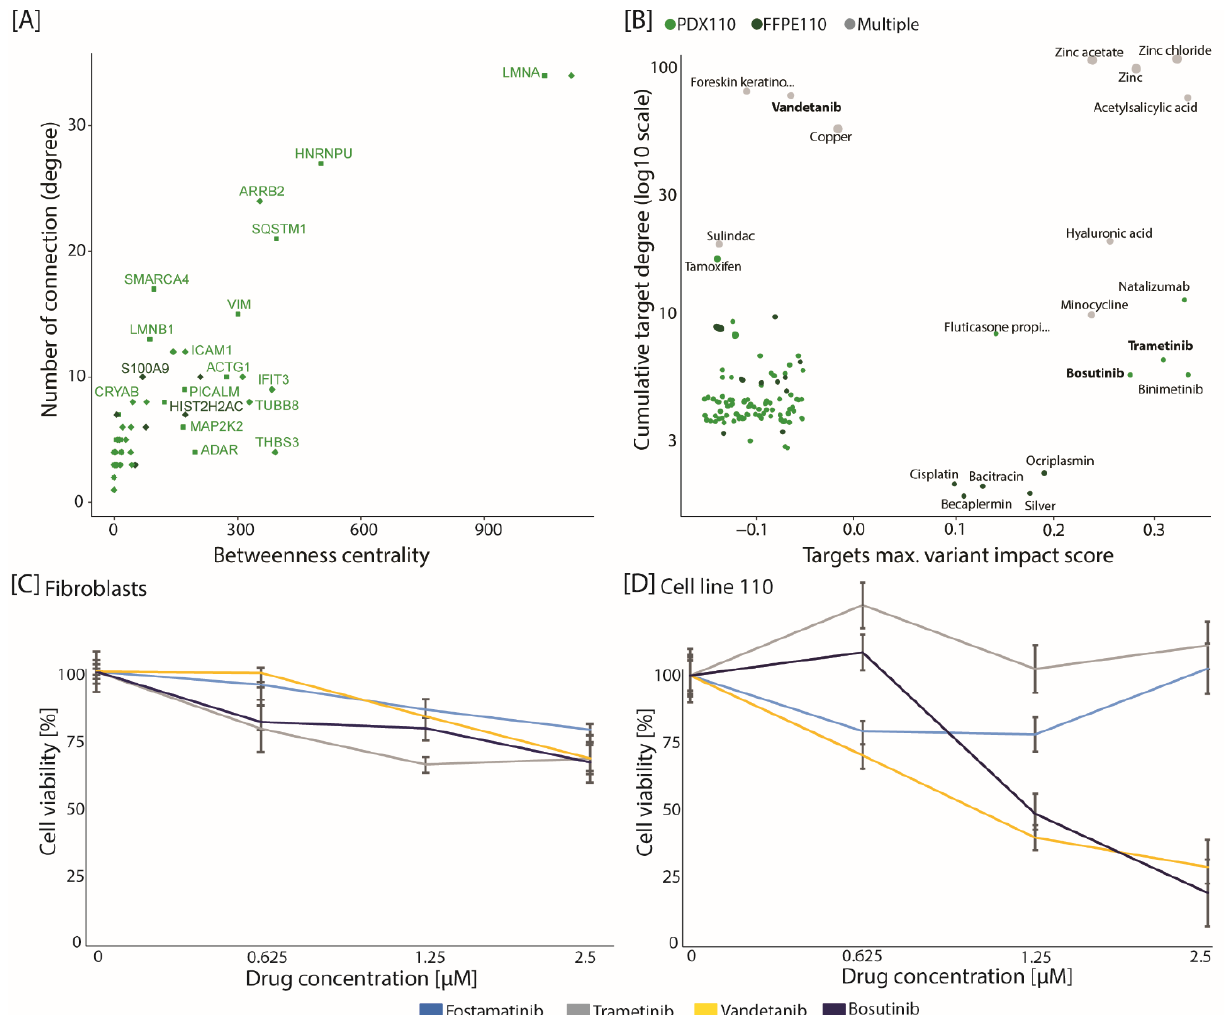
Figure 3. Integration of genomics, proteomics and drug database prioritizes actionable targets. ( A ) The interaction signaling network for patient ID 110 was generated based on list of significantly regulated proteins (diamond) and phosphorylation sites (square). This schematic displays the distribution of nodes in function of their betweenness centrality and number of connections. Only the top 200 entries are displayed (ranked based on their interaction degree). Entries are colored based on whether they were up-regulated in PDX (light green) or FFPE (dark green). ( B ) The drugs, interacting with entries from the interaction signaling network of patient ID 110, are displayed based on their targets’ maximum variant impact score and how many connections their targets had. Color-coding corresponds to whether all of the drug targets were specific for PDX (light green), FFPE (dark green) or common to both sample types (grey). ( C , D ) Cell viability assay for fibroblasts ( C ) and cell line of patient ID 110 ( D ) treated with either fostamatinib (blue), trametinib (grey), vandetanib (yellow) or bosutinib (dark blue). Cells were cultured for 24 h, and then treated with the depicted drugs at the indicated concentrations (0, 0.635, 1.25 and 2.5 µM) or DMSO as the control. Cell viability was determined by MTS assay 96 h later. Results expressed as a percentage of the control represent the mean of six replicates. The error bar represents the standard deviations of replicates.